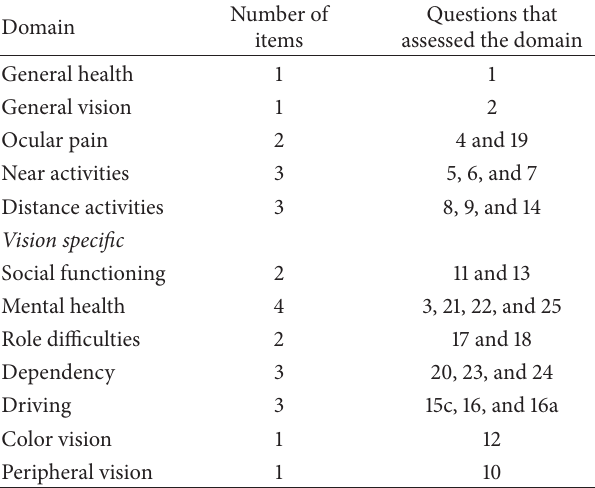
The mean preoperative and postoperative BCVA were 0.28 ± 0.15 (SD) and 0.97 ± 0.15 (SD) respectively, range